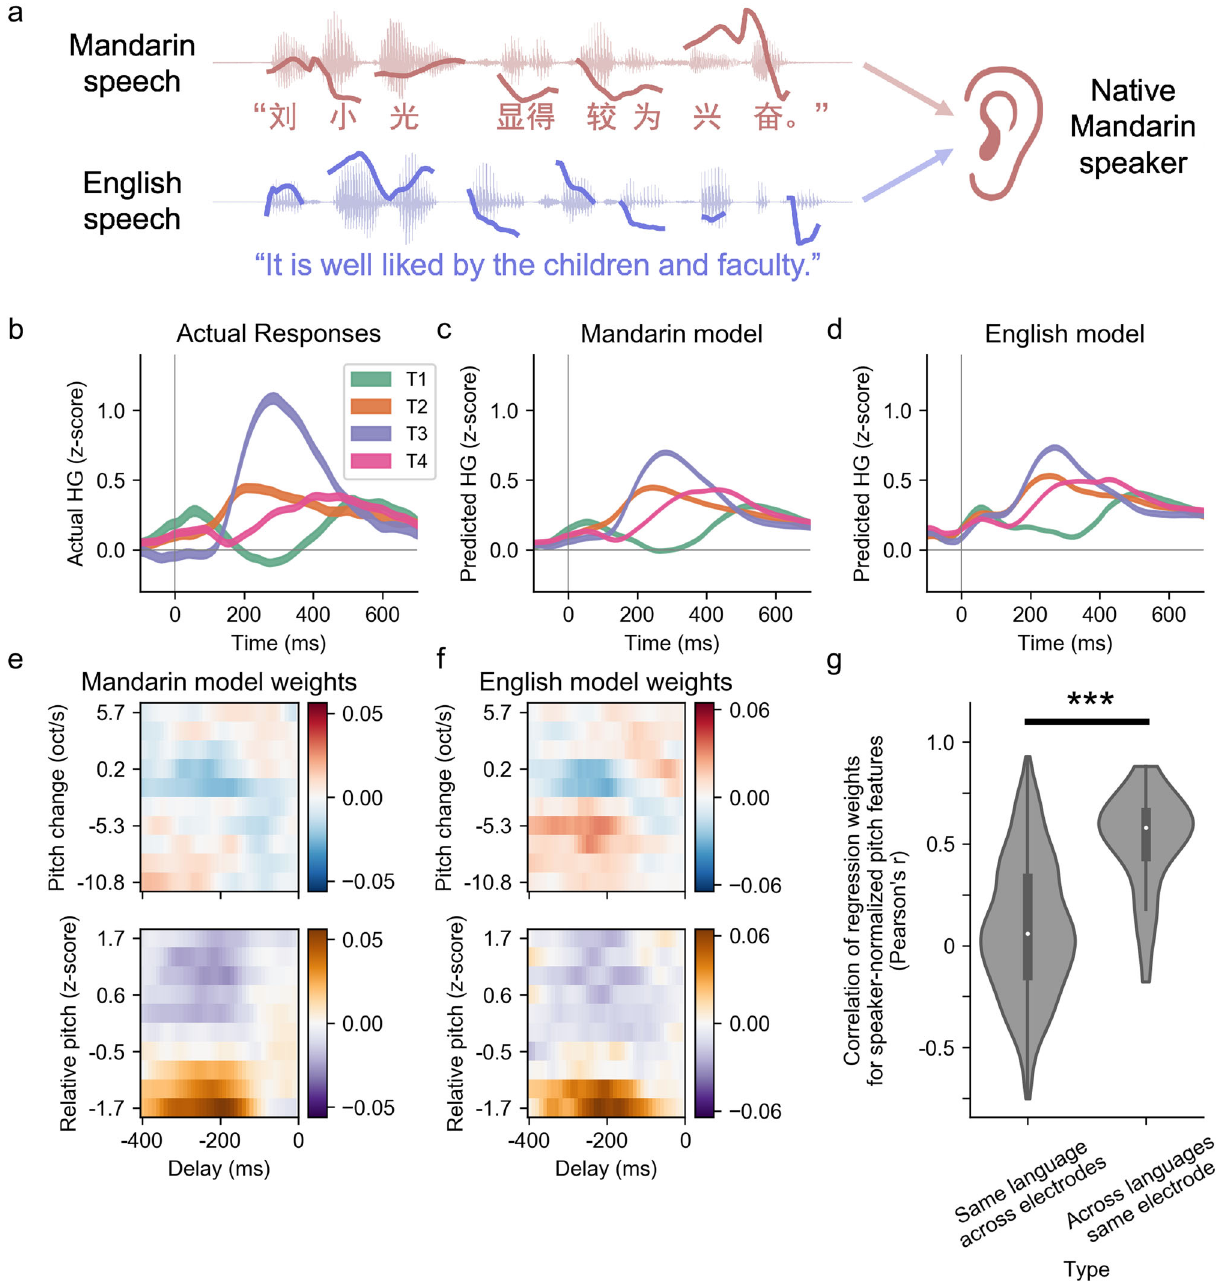
Fig. 4 Single-electrode encoding of speaker-normalized pitch is language-independent. a Participants listen to both Mandarin and English speech. Two encoding models are each trained using the neural responses to one language. b – f Representative example from one electrode. b Actual average evoked neural response to each lexical tone. c Predicted neural responses to each tone using the Mandarin encoding model, which is fi tted on neural responses to Mandarin speech. d Predicted neural responses using the English encoding model, which is fi tted on neural responses to English speech, showing a similar response pattern to b and c . e Regression weights for speaker-normalized pitch features over time from the Mandarin model whose predictions are shown in c . f Regression weights for speaker-normalized pitch features over time from the English model whose predictions are shown in d . The tuning to pitch is similar regardless of the stimulus language. g Comparing the empirical distributions of the correlation values between the regression weights for speaker- normalized pitch features. Central white dots represent the median values, and the thick vertical gray bars indicate interquartile range ( fi rst and third quantiles). The “ across languages same electrode ” comparison (right) shows signi fi cant positive correlations between the weights from the Mandarin model and English model within the same tone-discriminating electrode. The baseline distribution of the “ same language across electrodes ” comparison (left) shows no signi fi cant correlation between the regression weights from the Mandarin model of different tone-discriminating electrodes (*** p < 0.001, two-sided Mann – Whitney U